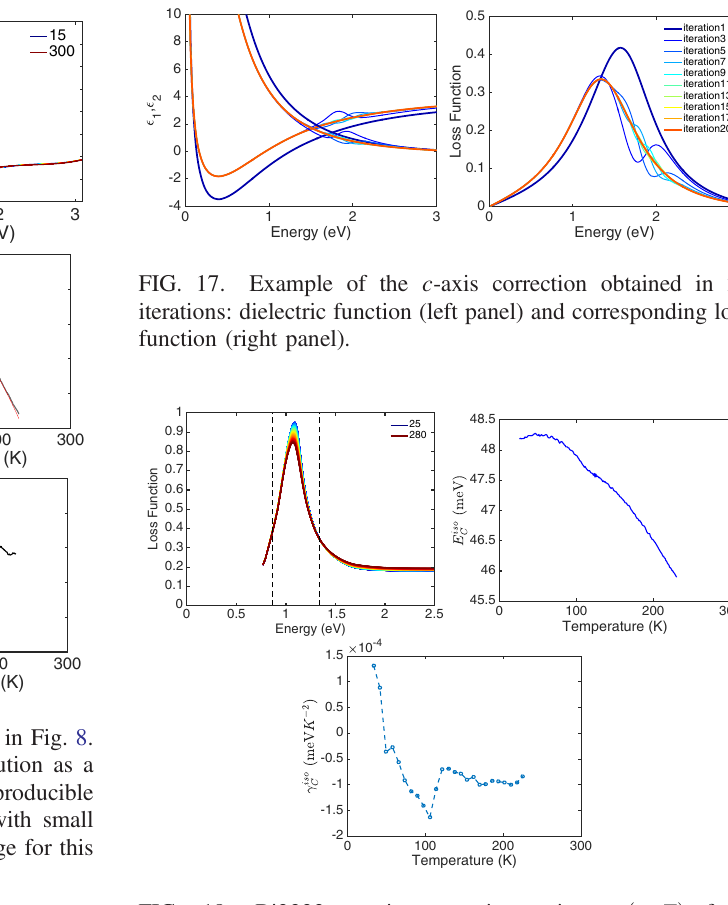
FIG. 18. Bi2223 c -axis correction using ϵ Ref. [77].